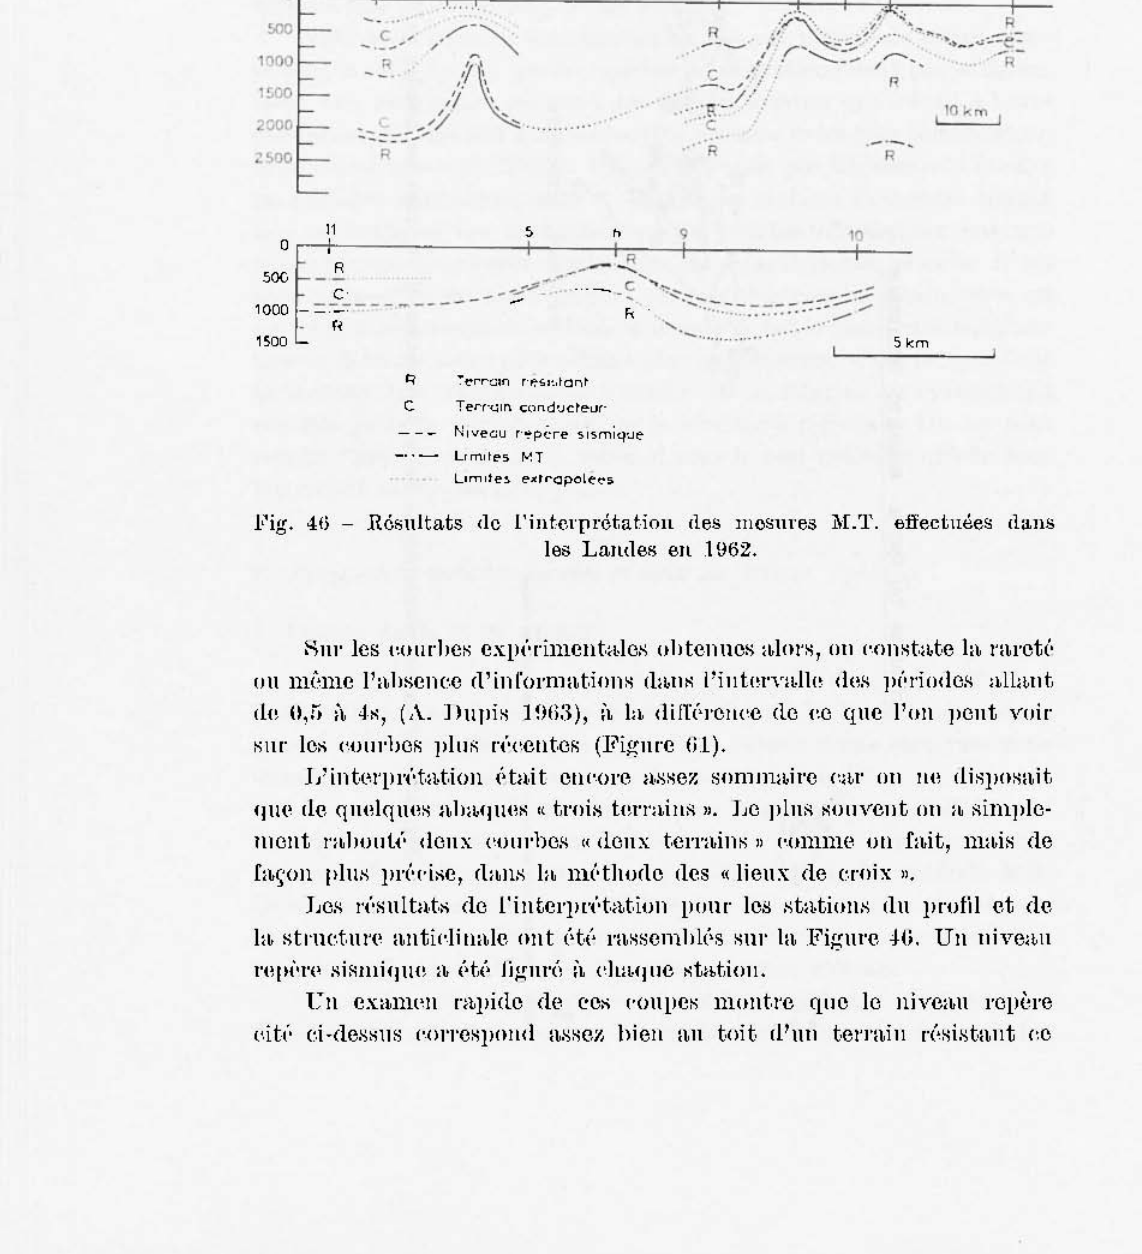
Fig. 4!i - Résnltats (le l'intel'pl'étatiolL des 1lI0SIll'eS M.T. effectllées dans les Landes en l